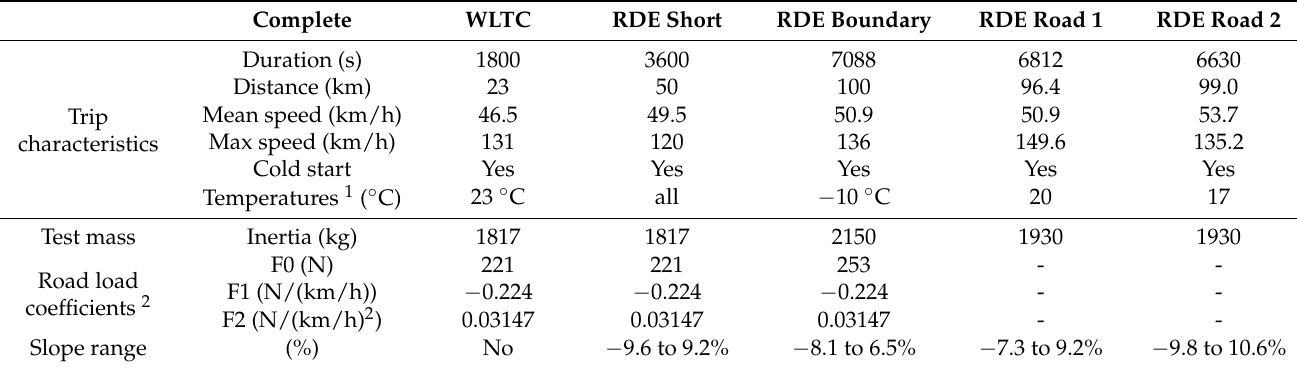
Table 1. Characteristics of the complete cycles conducted on the chassis dynamometer except RDE Road 1 and Road 2.